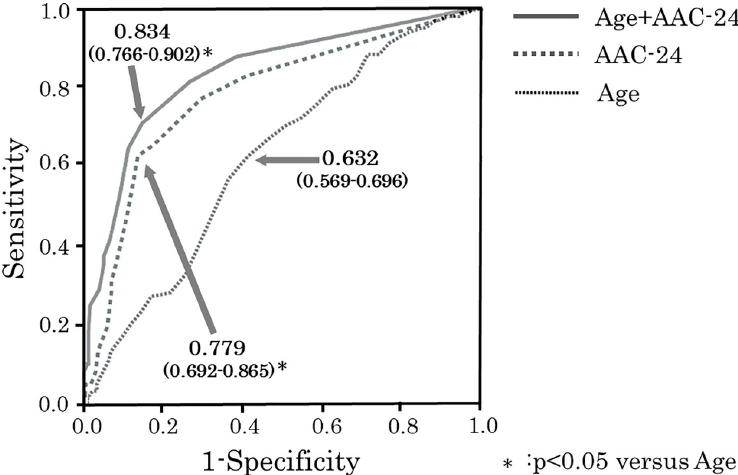
Fig 8. Receiver operating characteristic (ROC) curves for prediction of carotid artery plaque using AAC-24 scores, age, and a combination of these factors. Based on c-statistics, the area under the curve (AUC) for age was 0.632 [95% CI 0.569–0.696], and the AUC for AAC-24 was 0.779 [95% CI 0.692–0.865]. Combining AAC-24 with age significantly increased the AUC to 0.834 [95% CI 0.766–0.902].